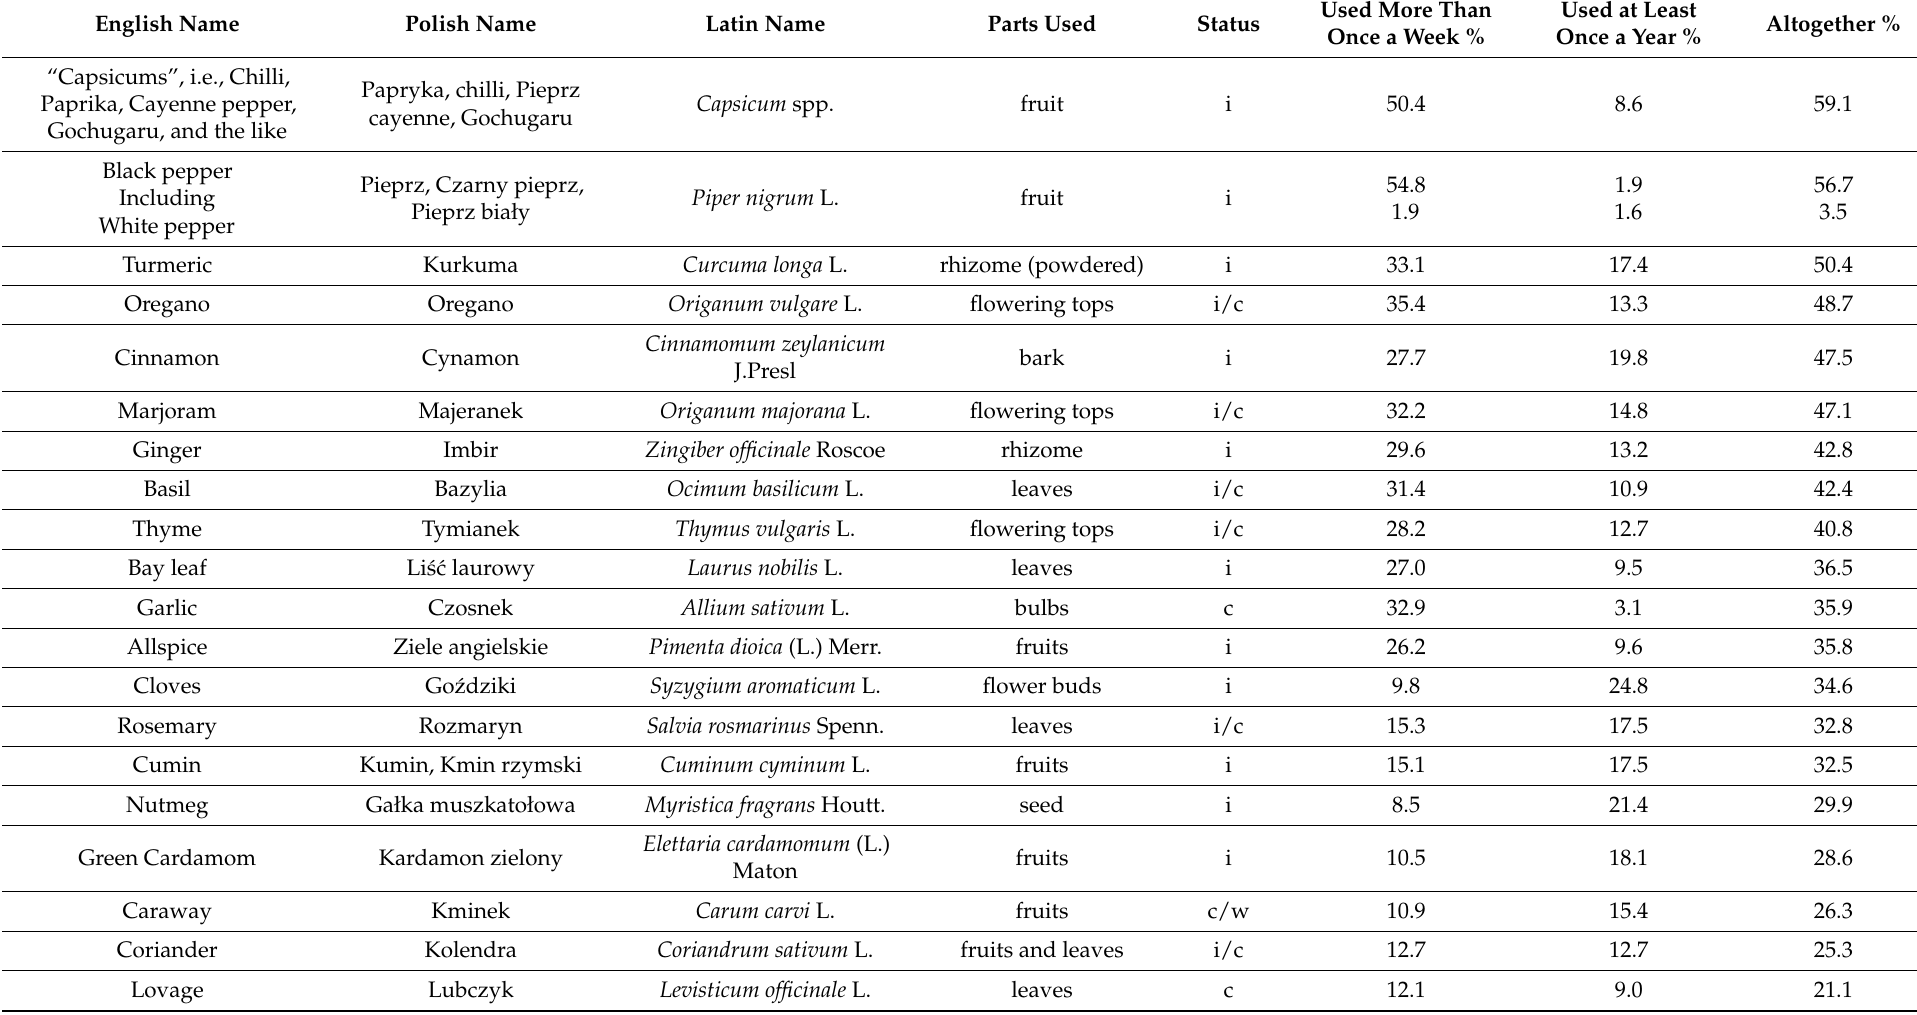
Table 1. Types of single-species botanical seasoning mentioned by more than one study participant. Spice mixes were